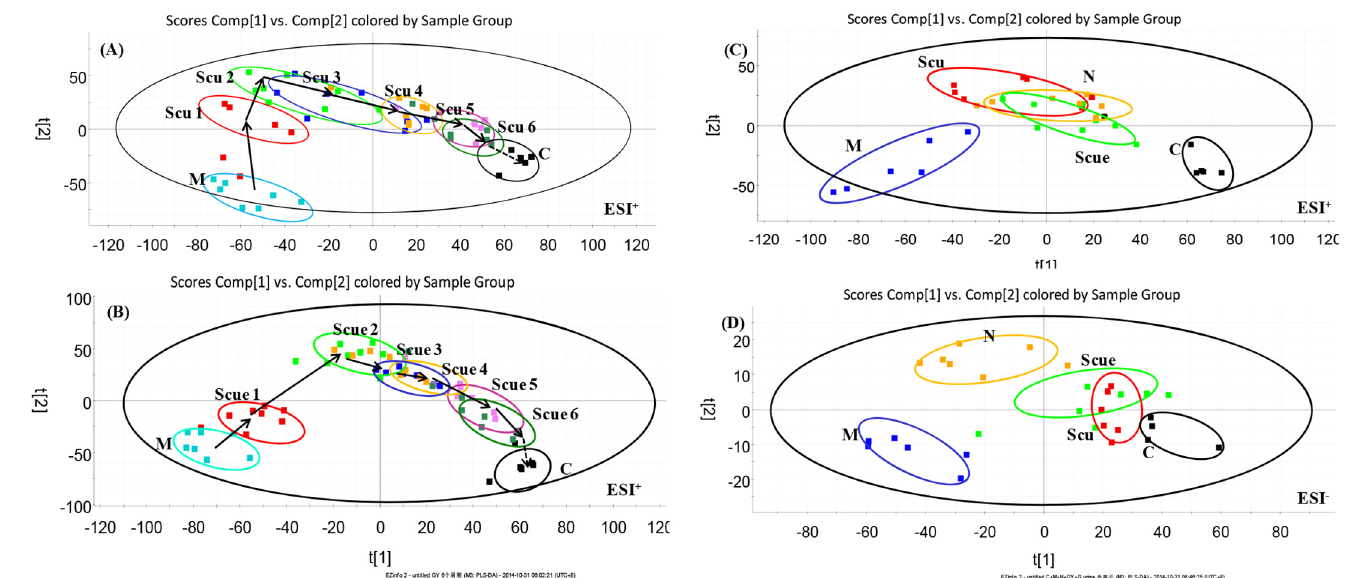
Fig 3. PLS-DA analytical results from urine samples of BCCAO rats treated with Scu (A) or Scue (B) at six therapeutic cycles in positive mode. C, sham-operated group (0 – 12 h); M, model group (0 – 12 h); Scu 1 – 6, after administration of Scu for 0 – 12 h (Scu1), 12 – 24 h (Scu2), 24 – 36 h (Scu3), 36 – 48 h (Scu4), 48h-60 h (Scu5) and 60 – 72 h (Scu6); Scue 1 – 6, after administration of Scue for 0 – 12 h (Scue1), 12 – 24 h (Scue2), 24 – 36 h (Scue3), 36 – 48 h (Scue4), 48h-60 h (Scue5) and 60 – 72 h (Scue6). PLS-DA analytical results from BCCAO rat urine samples treated with Scu, Scue, and nimodipine at 12 – 24 h in positive (C) and negative modes (D). C, sham-operated group; M, model group; Scu, after administration of Scu; Scue, after administration of Scue; N, after administration of nimodipine.